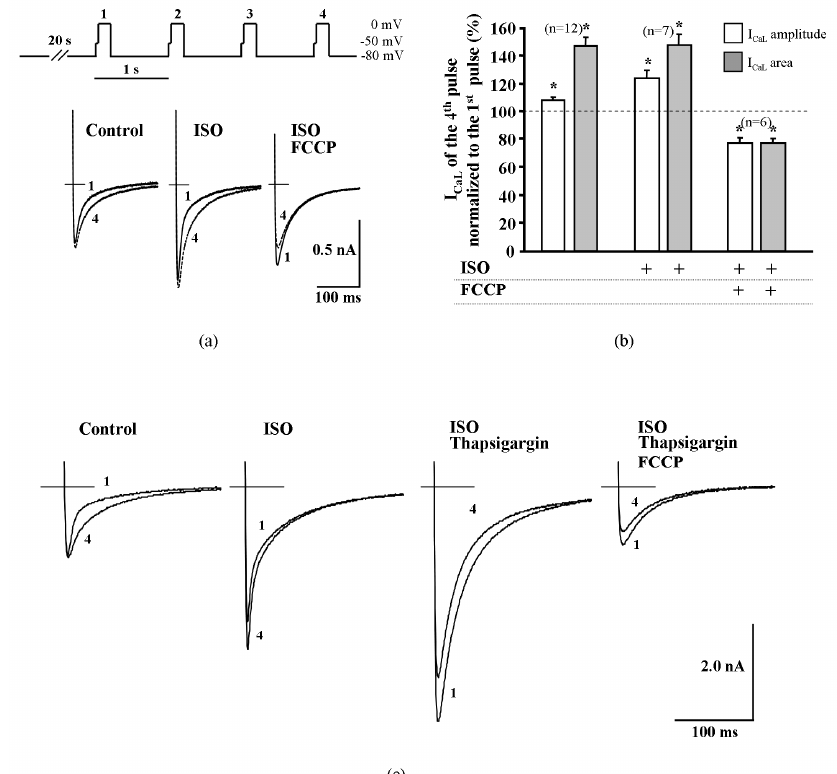
Figure 4. Fast facilitation of I CaL in rat ventricular cells is abolished by metabolic inhibition and by the suppression of cytosolic Ca 2+ release. ( a ) Depolarization protocol for the induction of fast facilitation of I CaL shown on top. In ISO-stimulated rat ventricular cells and in control conditions, increased frequency (to 1 Hz) depolarization induced an increase of I CaL amplitude and delayed the inactivation; FCCP abolished this effect in ISO-stimulated cells. ( b ) Peak amplitude and area (time integral) of I CaL during the fourth depolarizing pulse in control conditions, in ISO stimulated cells and during exposure of 0.1 µ mol/L of FCCP. Values are presented as means ± SEM for the number of cells indicated in parentheses. * p < 0.05 versus I CaL of the first pulse. ( c ) Suppression of cytosolic Ca 2+ release by thapsigargin abolished the increase of I CaL amplitude itself during increased frequency depolarization and FCCP additionally reduced I CaL amplitude.